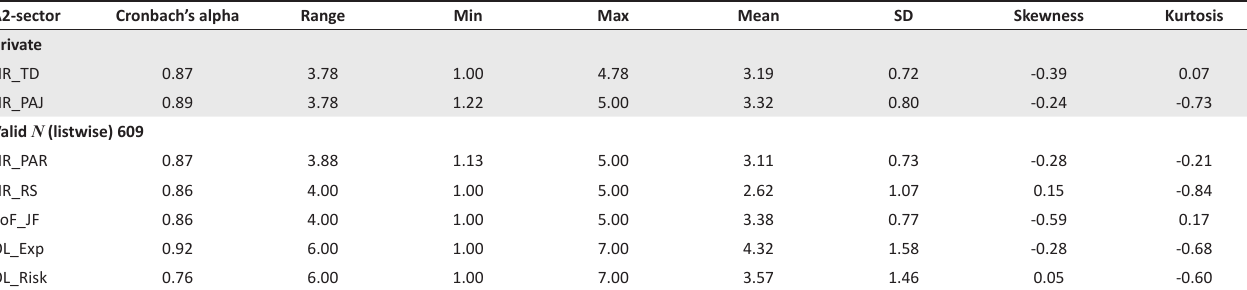
TABLE 2: Descriptive